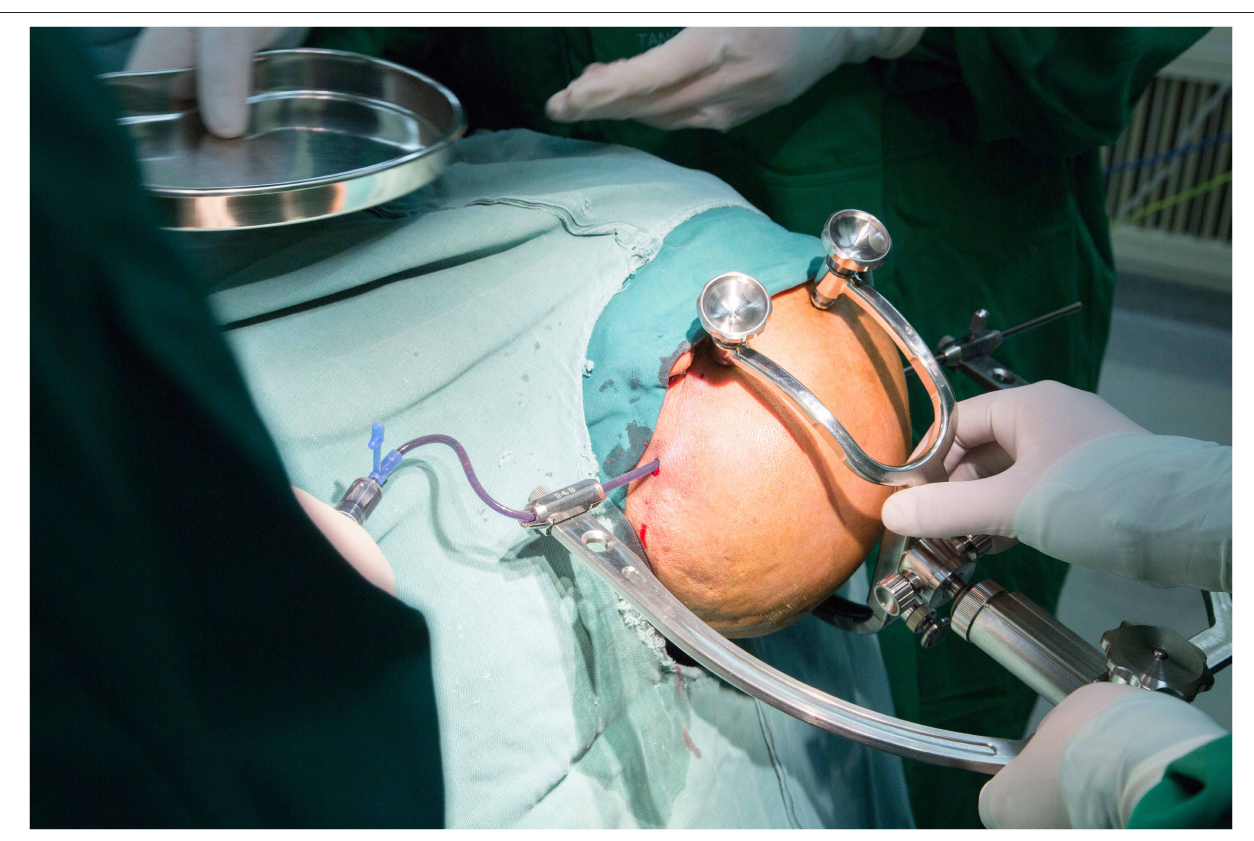
FIGURE 4 | Puncture and aspiration of the